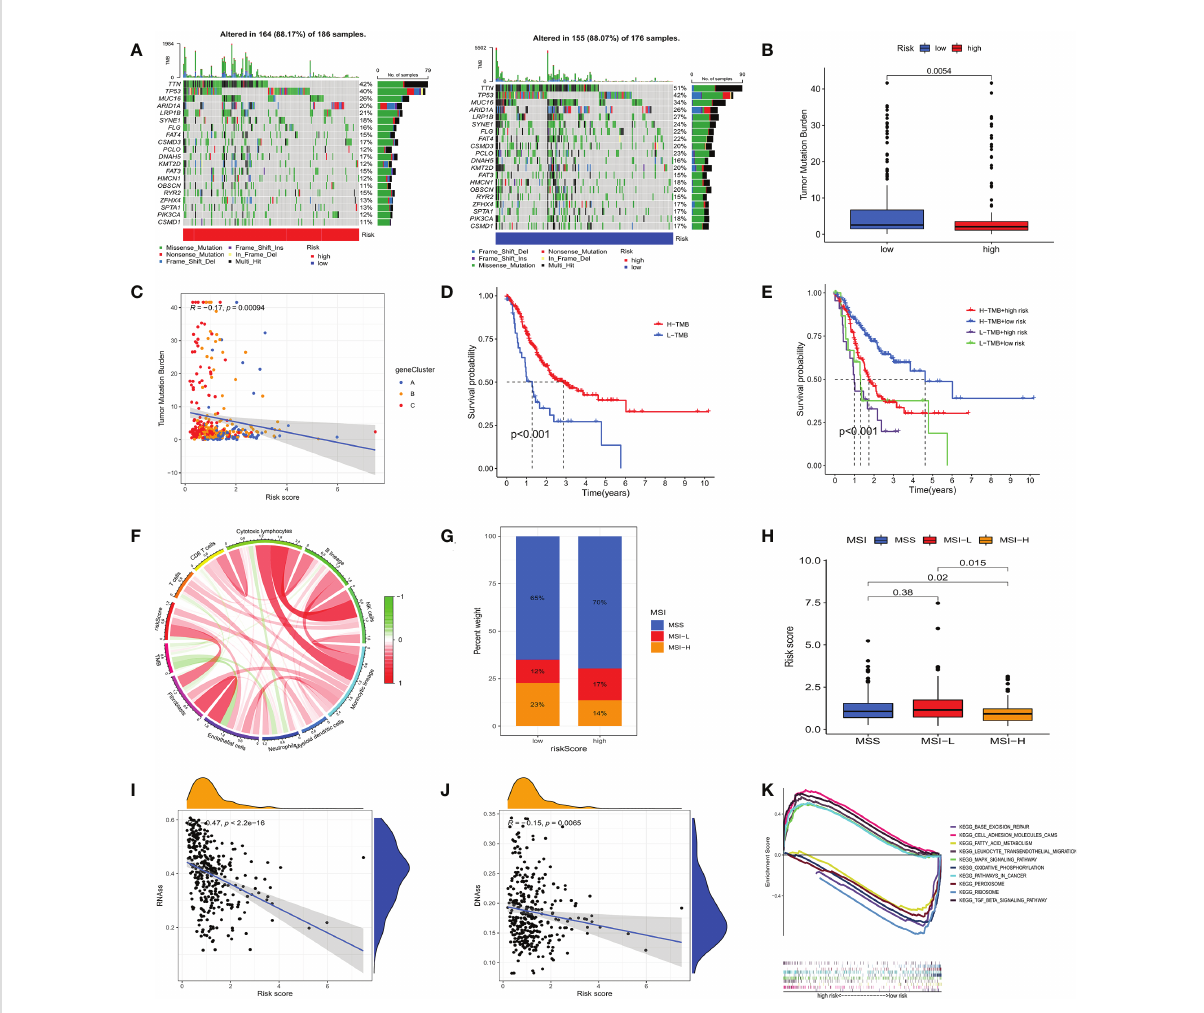
FIGURE 8 (A) Waterfall plots of somatic mutation characteristics in high- and low- risk groups. (B) The difference of TMB in different m7GRG _ Score groups. (C) Spearman correlation analysis between m7GRG _Score and TMB. (D) Survival analysis of high- and low- TMB groups. (E) Survival analysis of four groups of patients strati fi ed by m7GRG _Score and TMB. (F) The relationship between TMB and immune cells. Red represents positive correlation and green represents negative correlation. The shade of color represents the degree of correlation. (G, H) Relationship between m7GRG _Score and MSI. (I, J) Relationship between m7GRG _Score and CSC index. (K) GSEA signaling pathway enrichment analysis of high- and low- m7GRG_score groups. TMB, Tumor mutation burden; MSI, Microsatellite instability; CSC, tumor stem cell; GSEA, Gene Set Enrichment